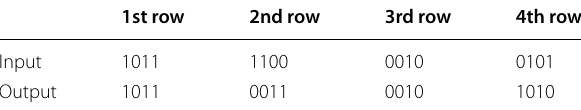
Table 3 Sample input and output of scan